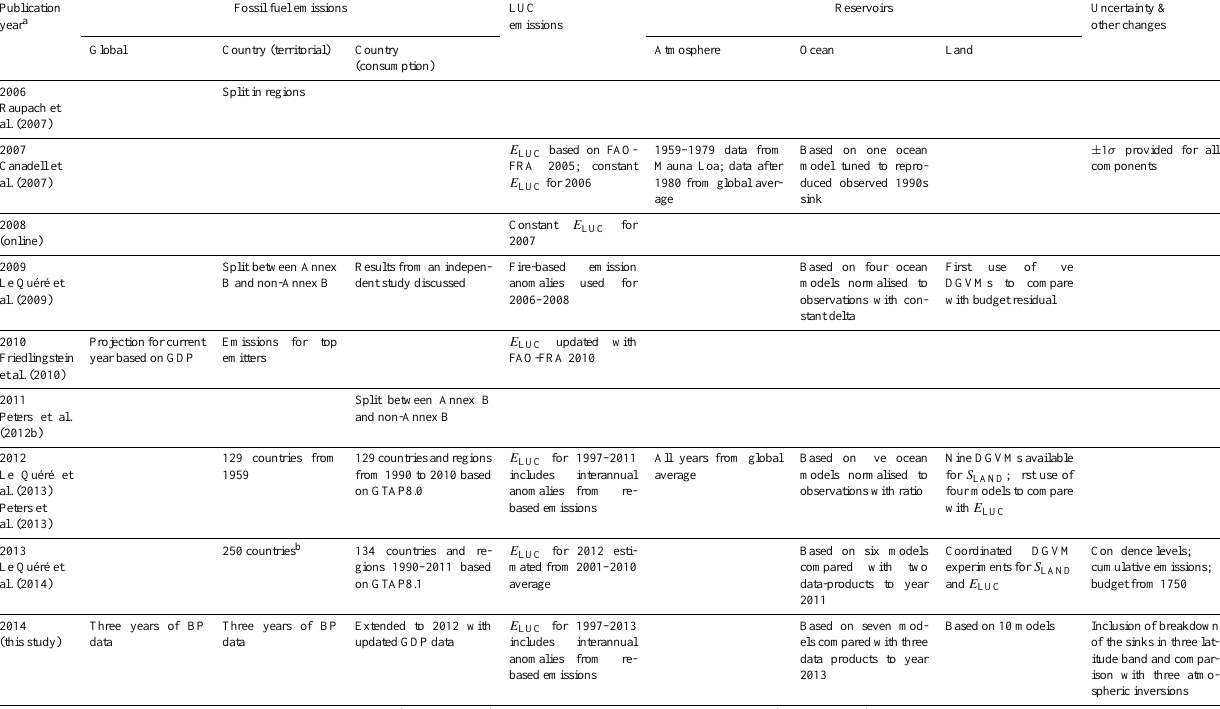
Table 3. Main methodological changes in the global carbon budget since first publication. Unless specified below, the methodology was identical to that described in the current paper. Furthermore, methodological changes introduced in one year are kept for the following years unless noted. Empty cells mean there were no methodological changes introduced that